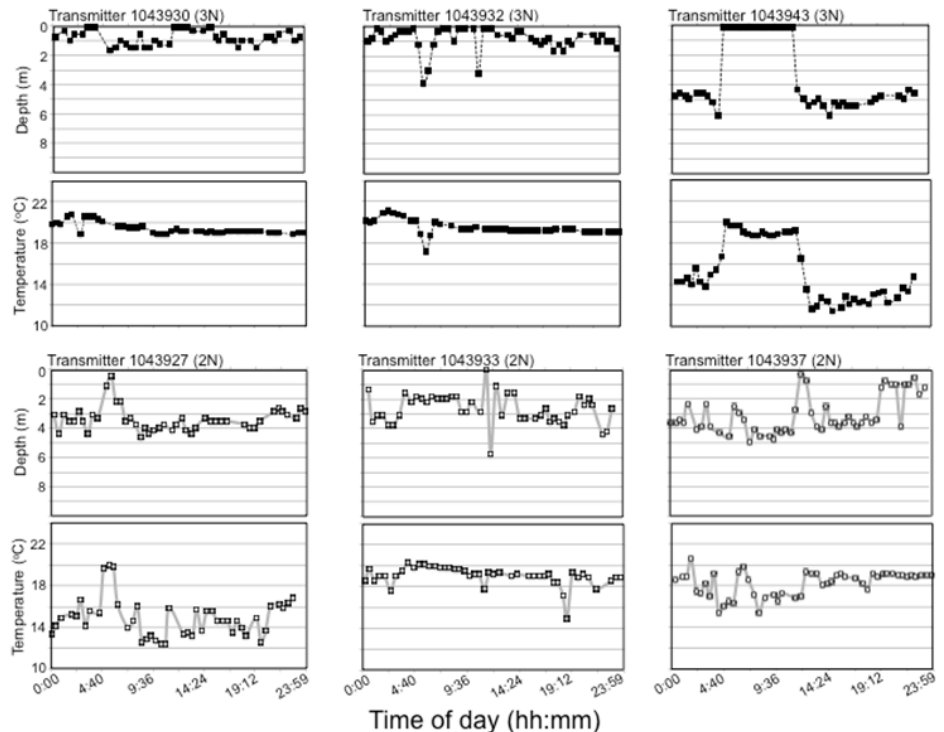
Figure 5. Twenty-four hour temperature and depth habitat utilization by diploid ( ○ ) and triploid ( ■ ) Blackwater rainbow trout ( Oncorhynchus mykiss ) in Pete’s Pothole on 10 July 2008 as determined through telemetry (Vemco VP TP transmitters).